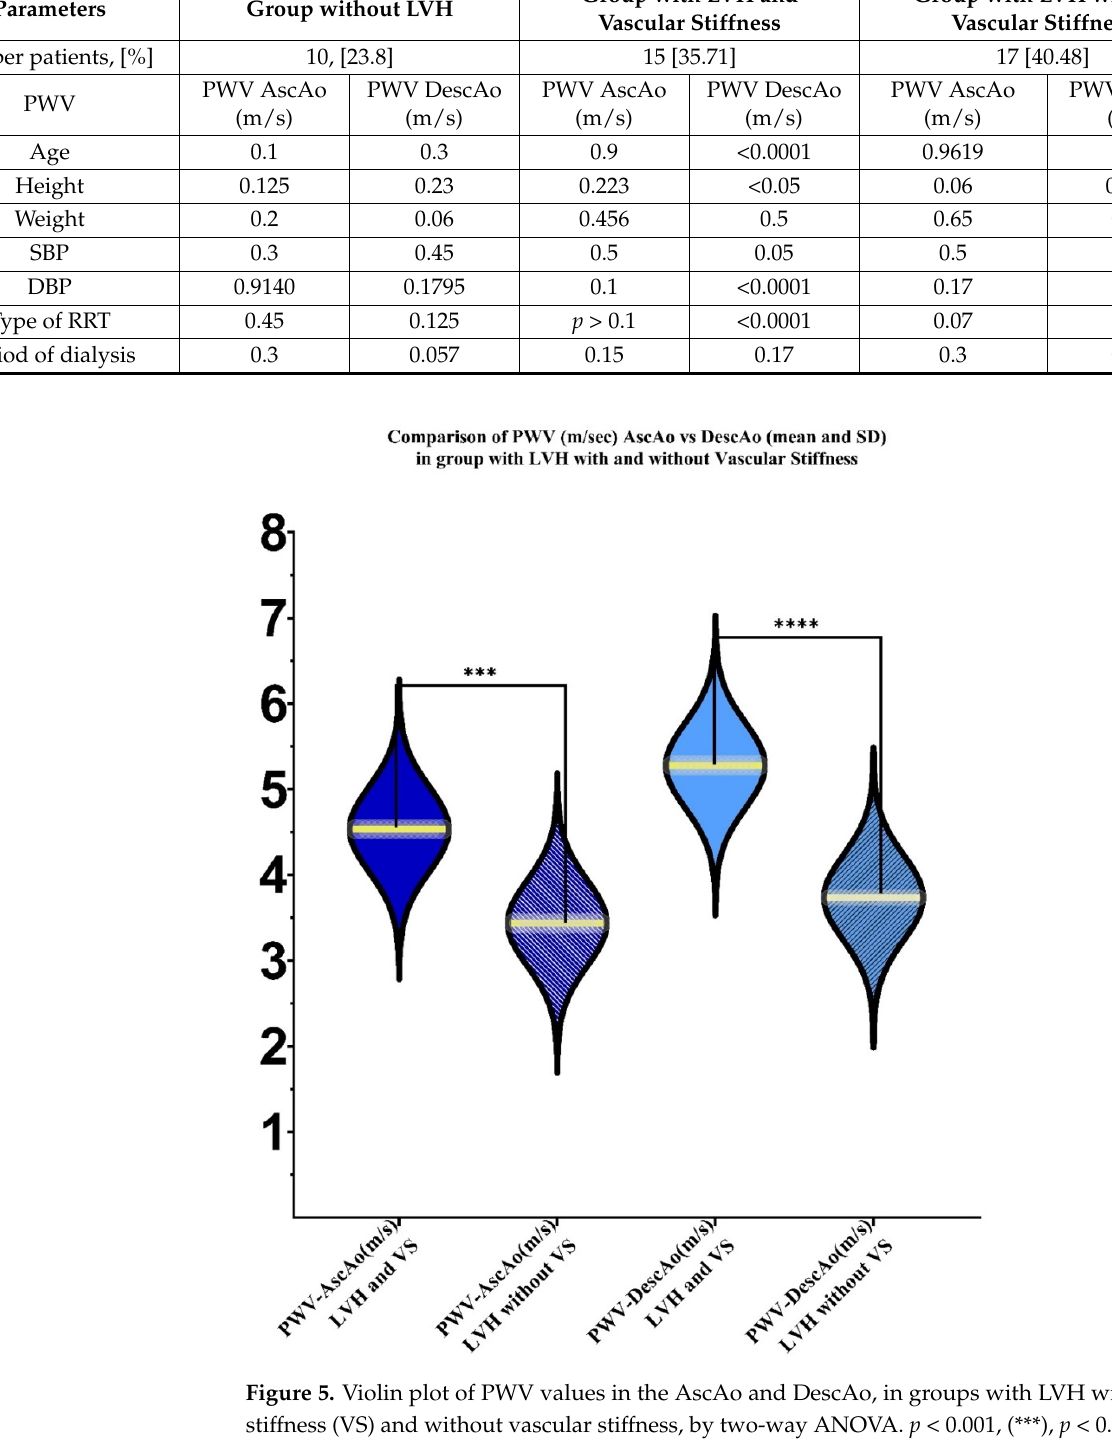
Figure 6. Distribution of increased PWV depending on location in the aorta (vascular dysfunction group).